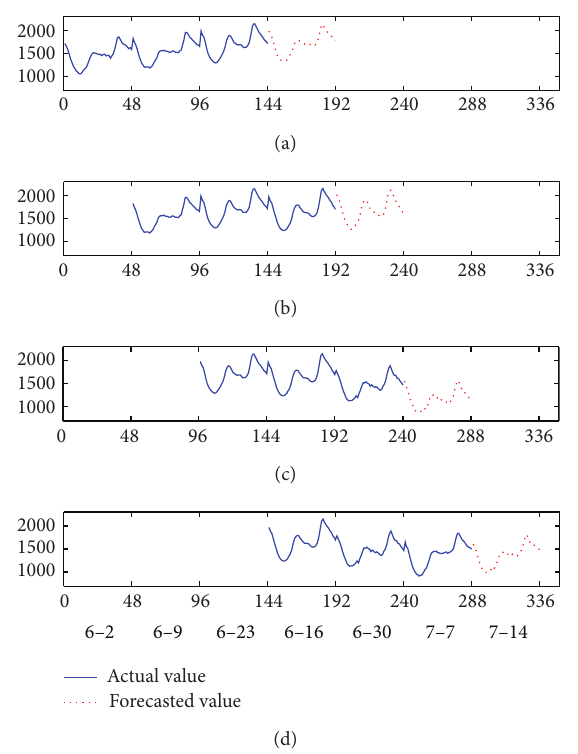
Figure 4: Forecasted load demand values by seasonal ARIMA mod- els.